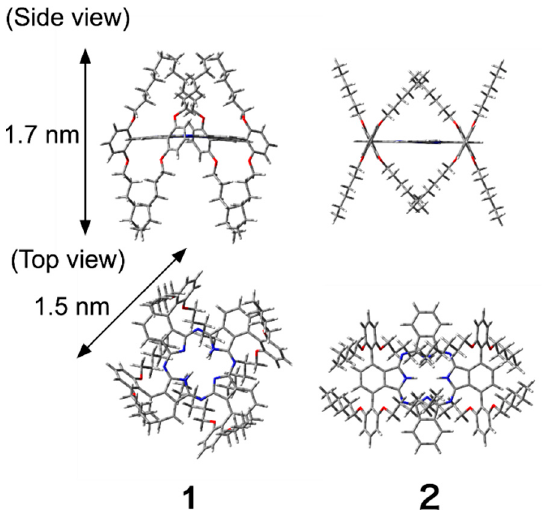
Figure 5. Molecular dimensions of 1 and 2 optimized by B3LYP/6-31G* level of Gaussian 16 (Gaussian, Inc., Wallingford, CT, USA).